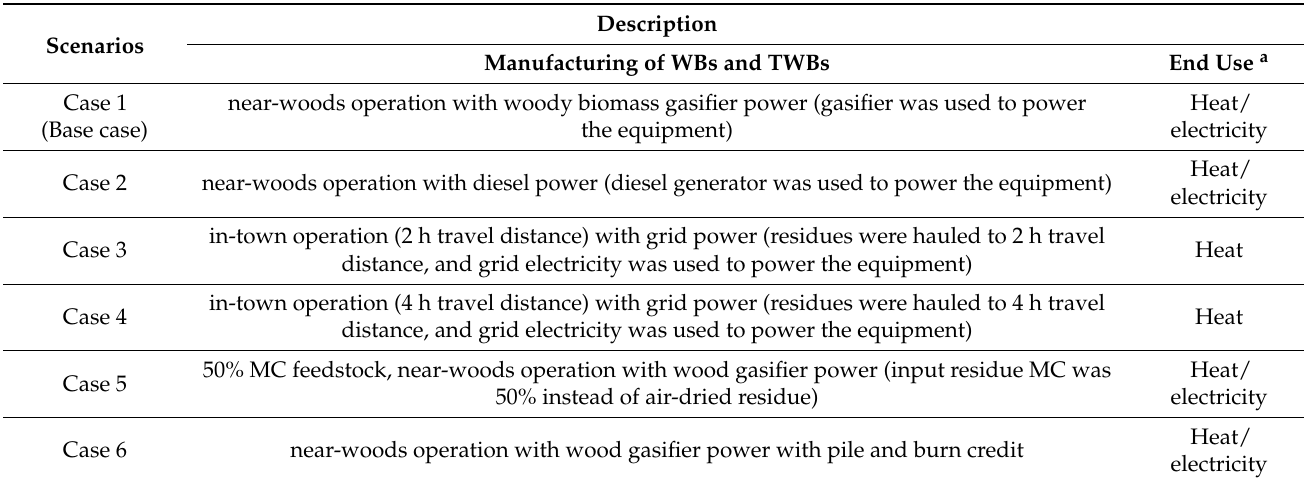
Table 2. Description of the scenarios